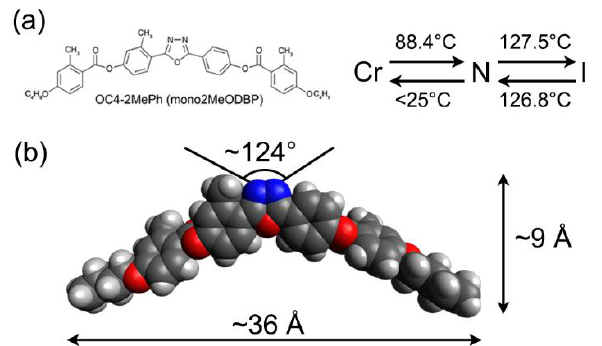
Figure 1. ( a ) Chemical structure and phase diagram of OC4-2MePh(mono2MeODBP) upon heating and cooling; ( b ) 3D model of the molecule with typical dimensions and bending angle.